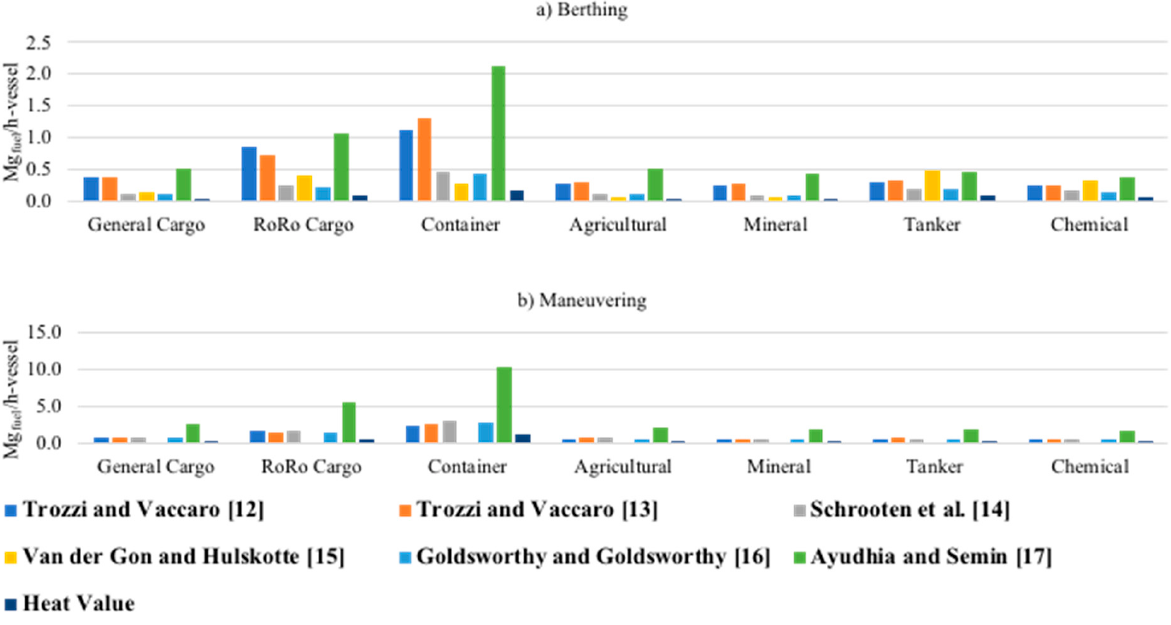
Figure 8. Annual average fuel consumption (Mg fuel /h-vessel) for each method in ( a ) berthing and ( b ) maneuvering position.